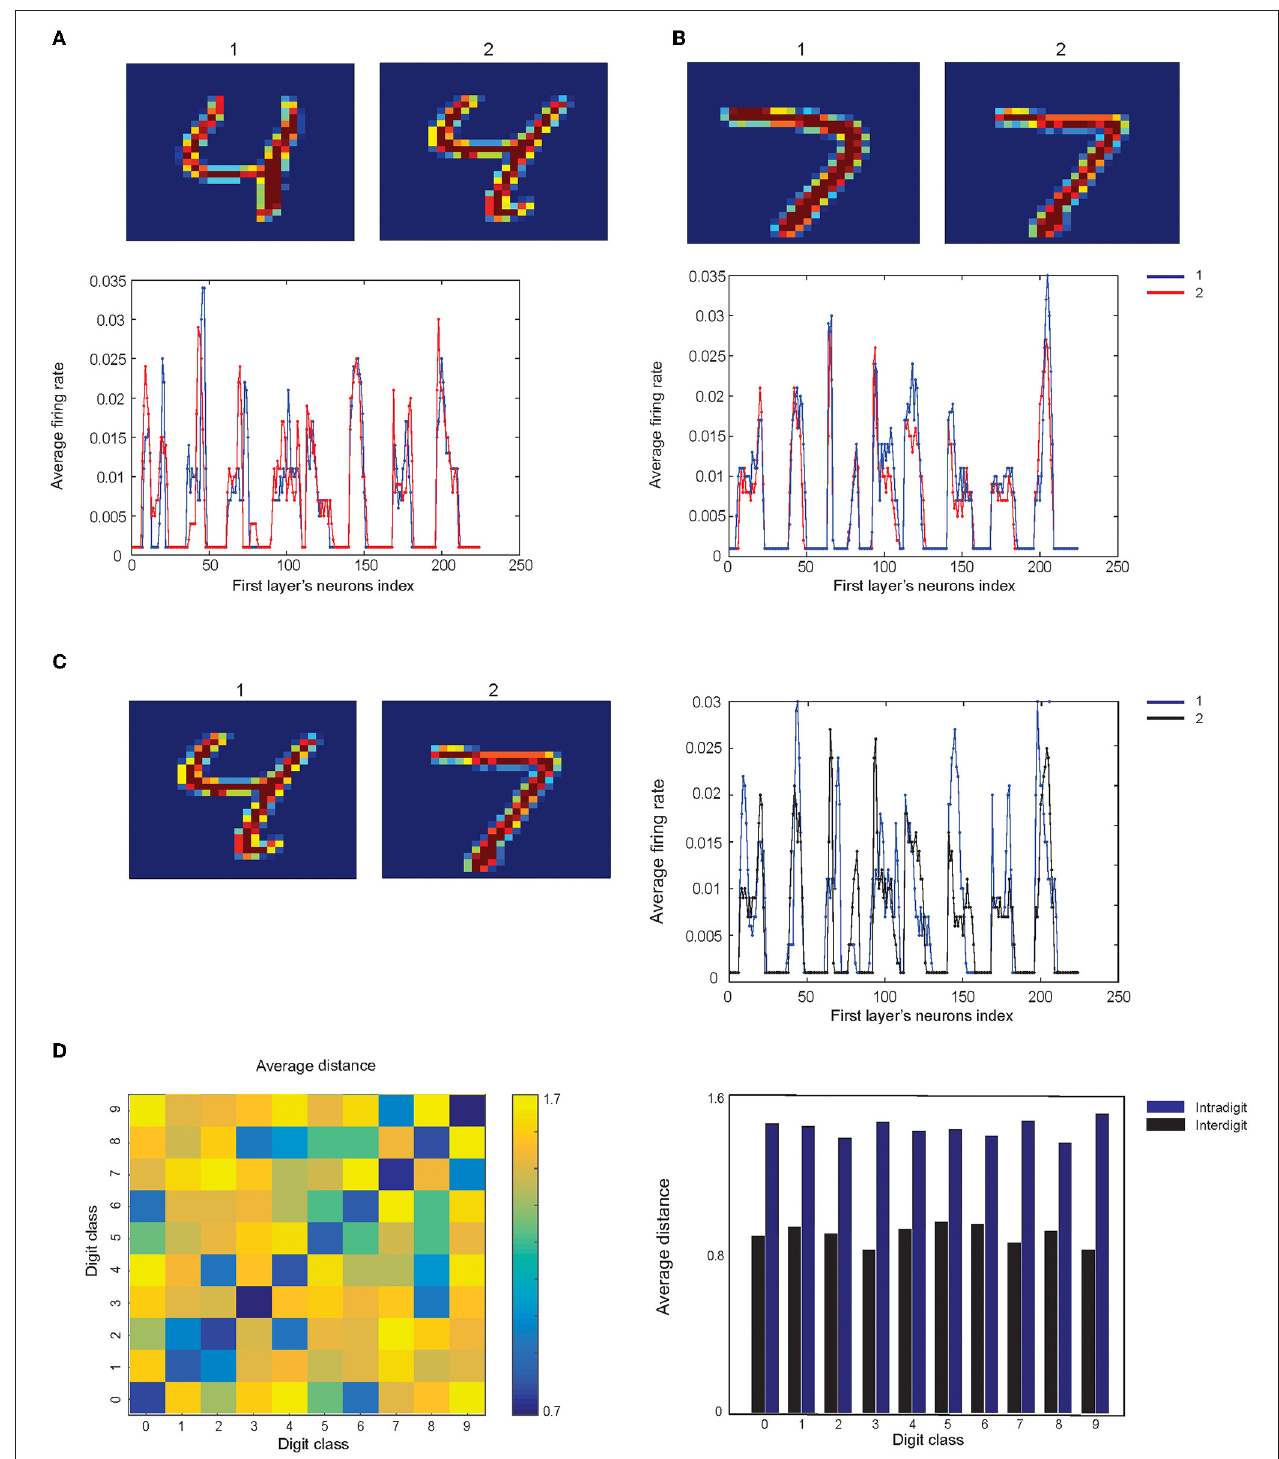
FIGURE 4 | Comparison of the neuronal representation of images from same classes and from different classes. (A) Two samples from the dataset are selected for digit “4”’and (B) for digit “7”. (C) Two samples from digit “4” and “7” and the neuronal activity of the first layer are compared. (D) Matrix of the average distance between the pairs of the neuronal representation of training samples. The results show that images from the same digit class have lower distance compared to the samples from different digit classes (right panel).